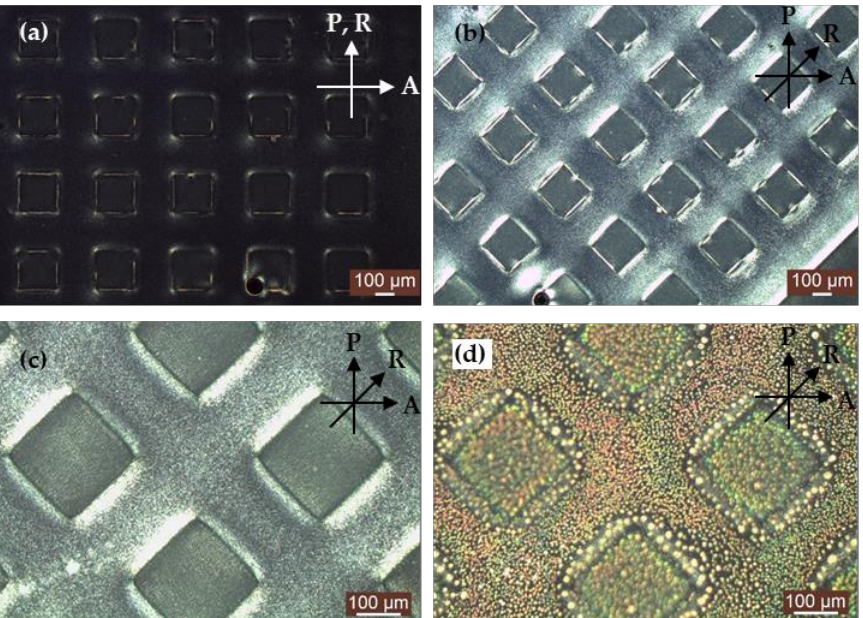
Figure 3. Microscopic images of patterned PDLC films under crossed polarizers at ( a ) R//P; ( b ) 45° between R and P; ( c ) without acetone; ( d ) with acetone. P and A denote the transmission axes of the polarizer and analyzer, respectively, and R denotes the rubbing direction.